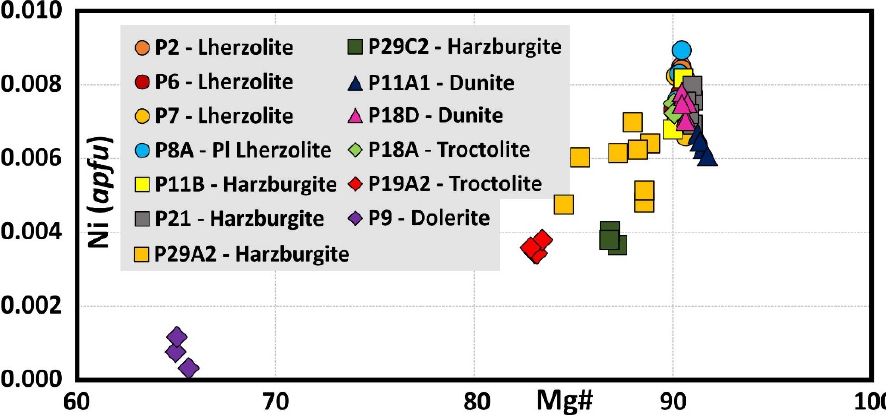
Figure 19. Relationship between Ni ( apfu ) and Mg# = [Mg/(Mg + Fe 2+ ) × 100] atomic ratio in olivine.